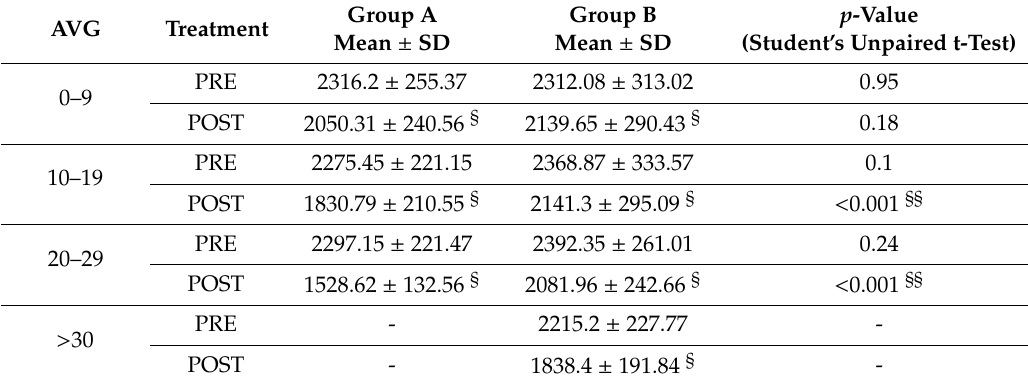
Table 7. Intra- and inter- group of subgroups divided by AVG range in endothelial cells for groups A (BSS ~20 ◦ C) and B (BSS 2.7 ◦ C) (pre- and post- treatment).